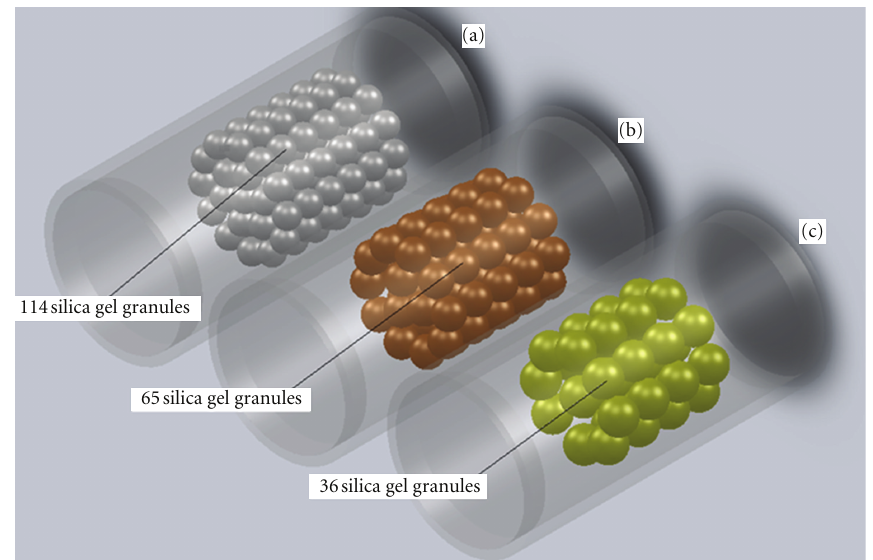
Figure 4: The three adsorption bed tube containing the numerically created example packing with (a) 36 granules, (b) 65 granules, (c) 114 granules.